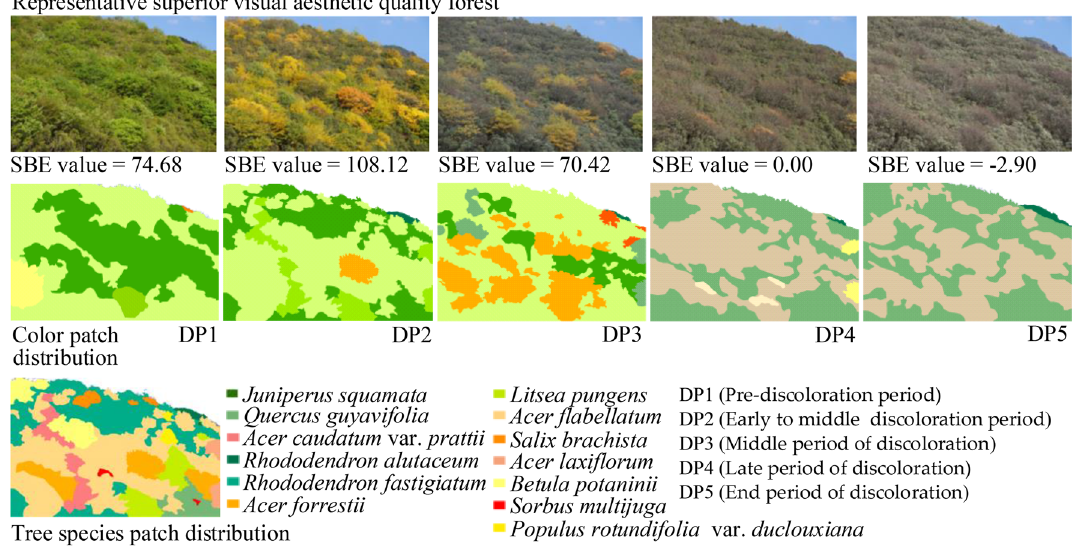
Figure 8. Overlay analysis of tree species patch distributions and color patch distributions in one representative superior slope forest through the autumn discoloration period. SBE scenic beauty